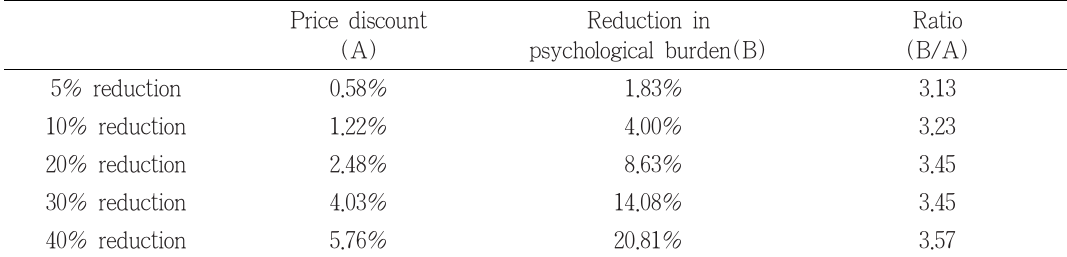
<Table 6> Welfare impact: reduction in price vs social